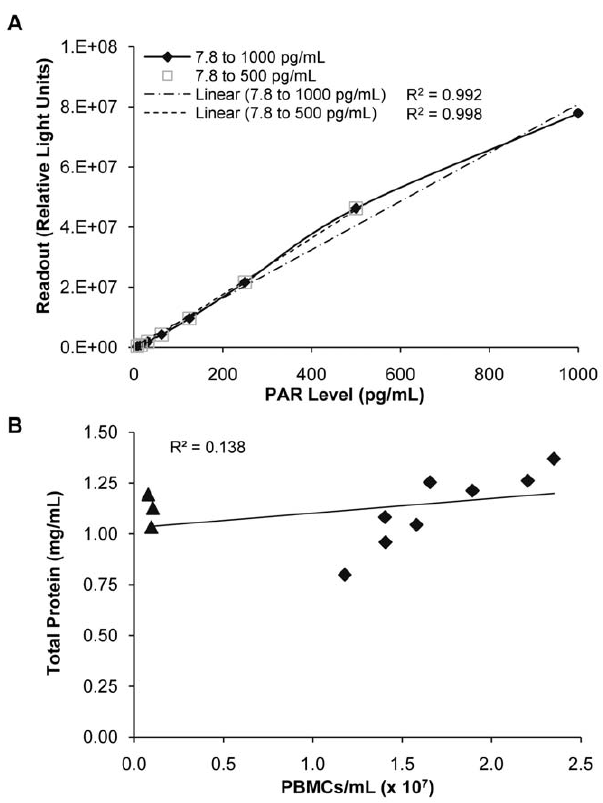
Figure 1. Dilution linearity of the PAR polymer standards and protein content from isolated PBMC samples. (A) Dilution linearity of the PAR polymer standards was determined during quantitative validation of the PAR immunoassay for PBMCs. Concen- trations of PAR standards ranged from 7.8 to 1000 pg PAR/mL. (B) Total protein content (bicinchoninic acid protein assay) for isolated PBMCs (counted by hemocytometer) from 11 healthy volunteers. Triangles indicate samples where plasma protein contamination skewed the total protein readout when compared to cell number.